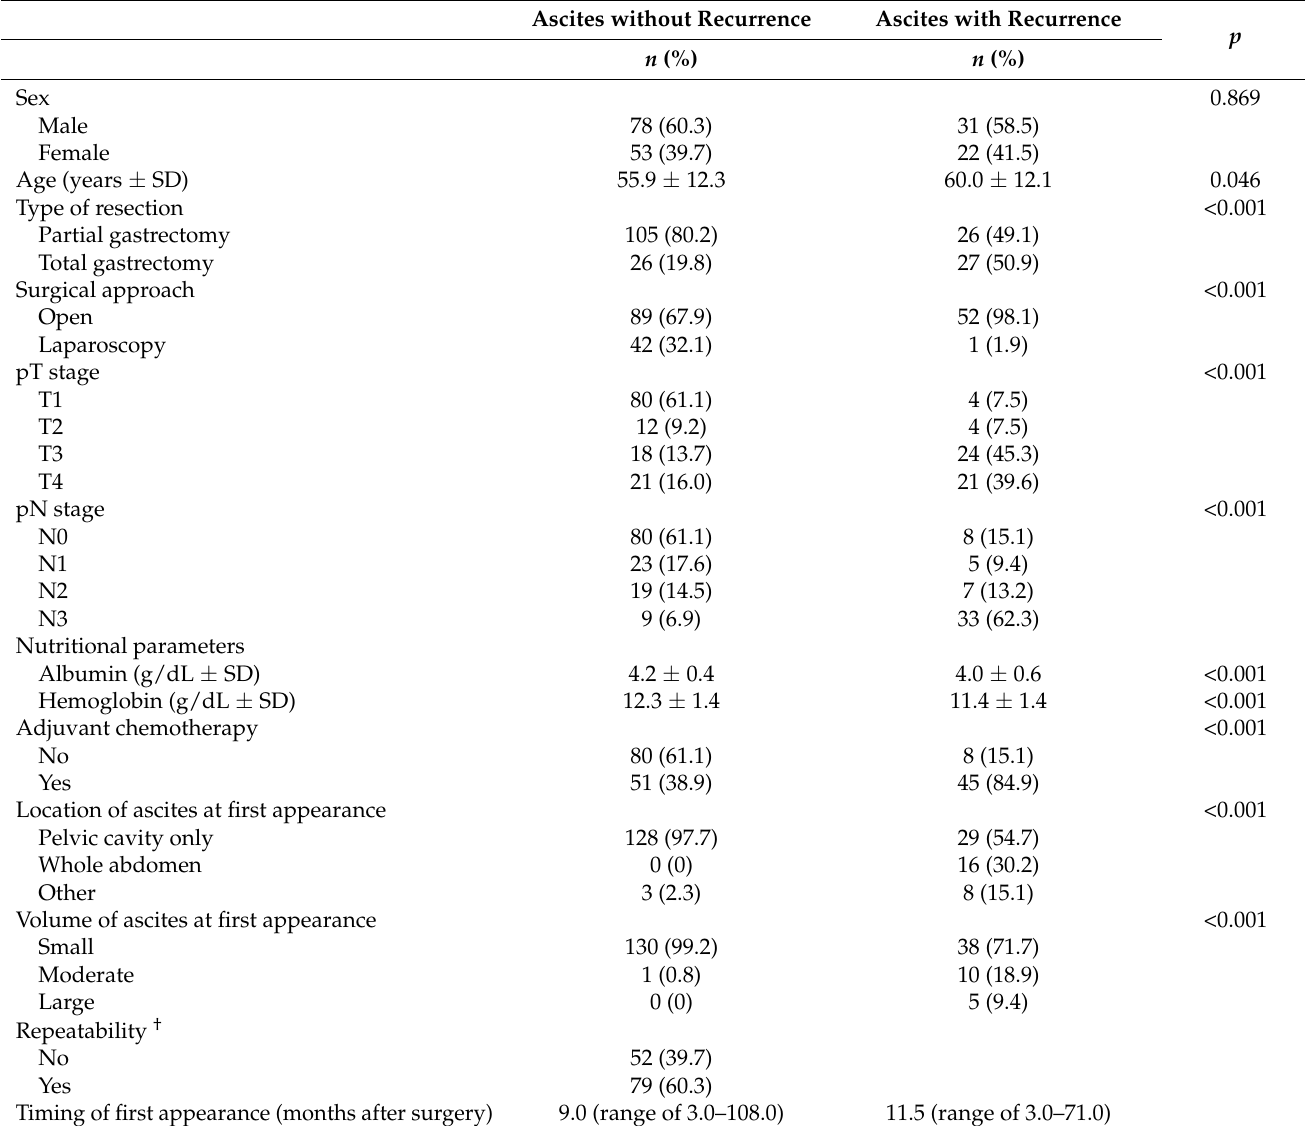
Table 1. Clinicopathologic